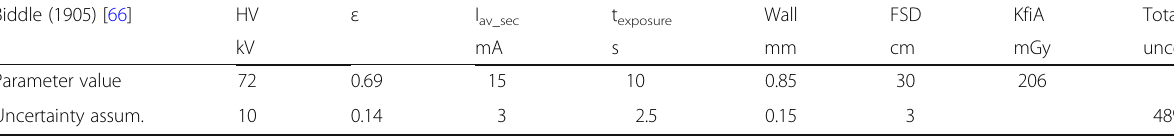
Table 9 Uncertainty estimate for a case with information on secondary circuit Biddle (1905) [66] HV ε I